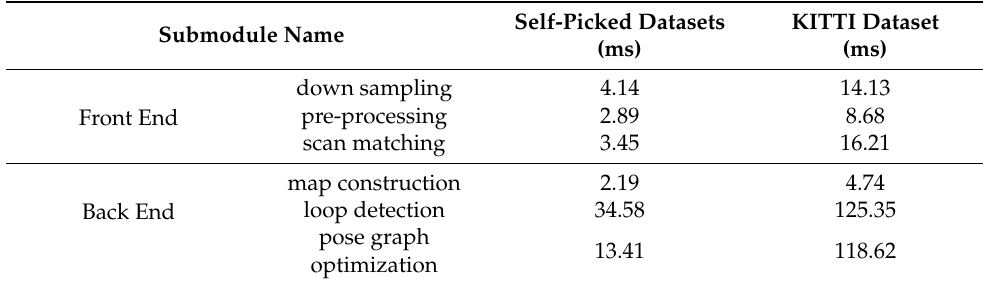
Table 4. Average running time statistics for each major